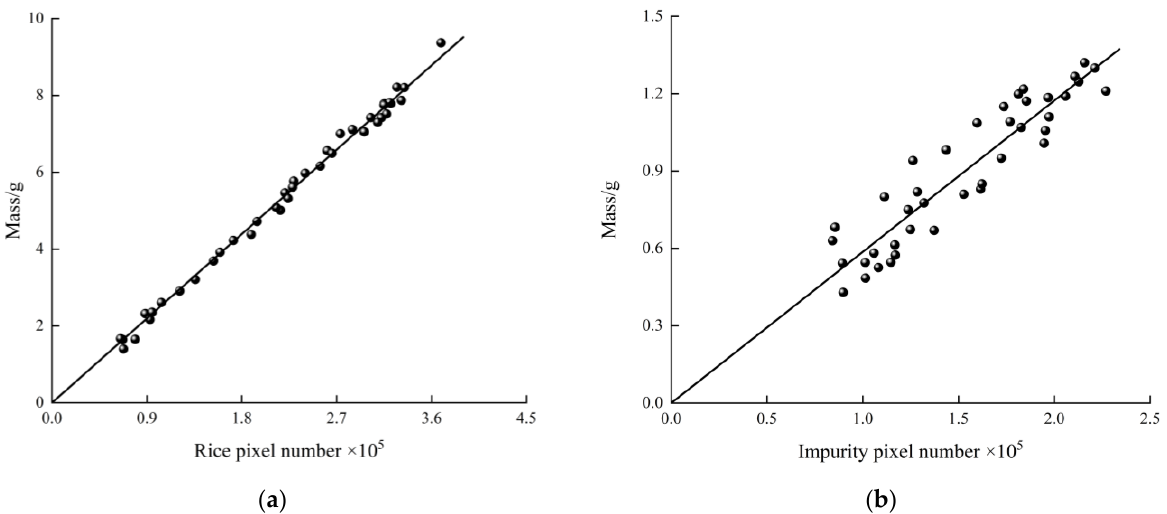
Figure 17. The relationship between pixel number and mass. ( a ) Rice; ( b ) impurity.